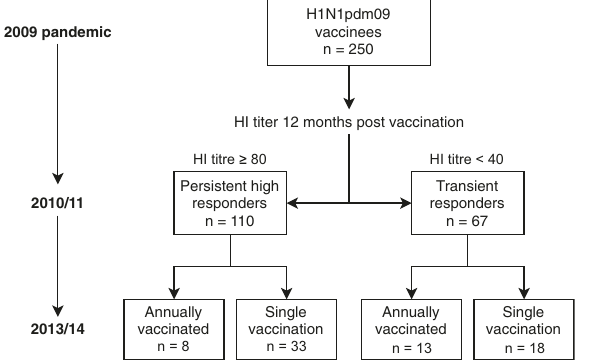
Fig. 1 Study design. Healthcare workers (HCWs) were vaccinated in 2009 with the AS03-adjuvanted low-dose (3.75 μ g HA) pandemic H1N1pdm09 vaccine ( N = 250) 10 . Blood samples were collected prior to pandemic vaccination in 2009 and annually before the